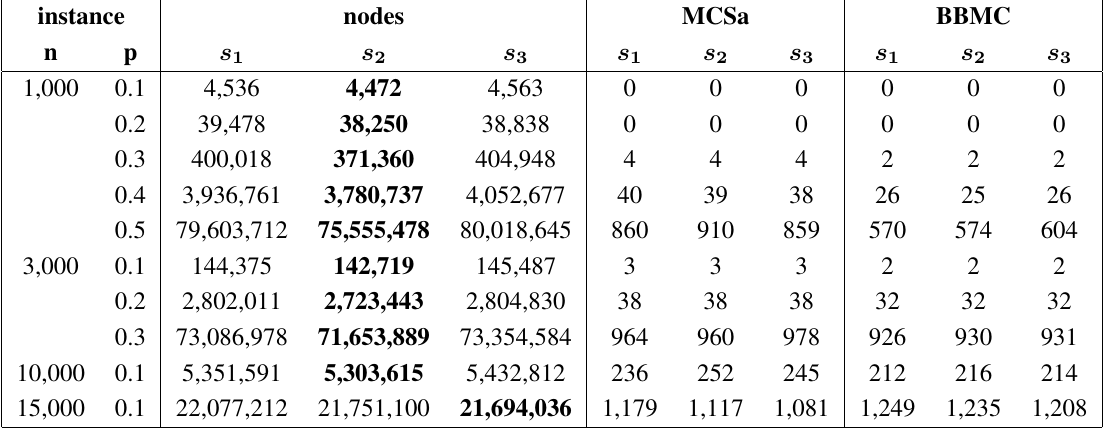
Table 6. Large random graphs, sample size